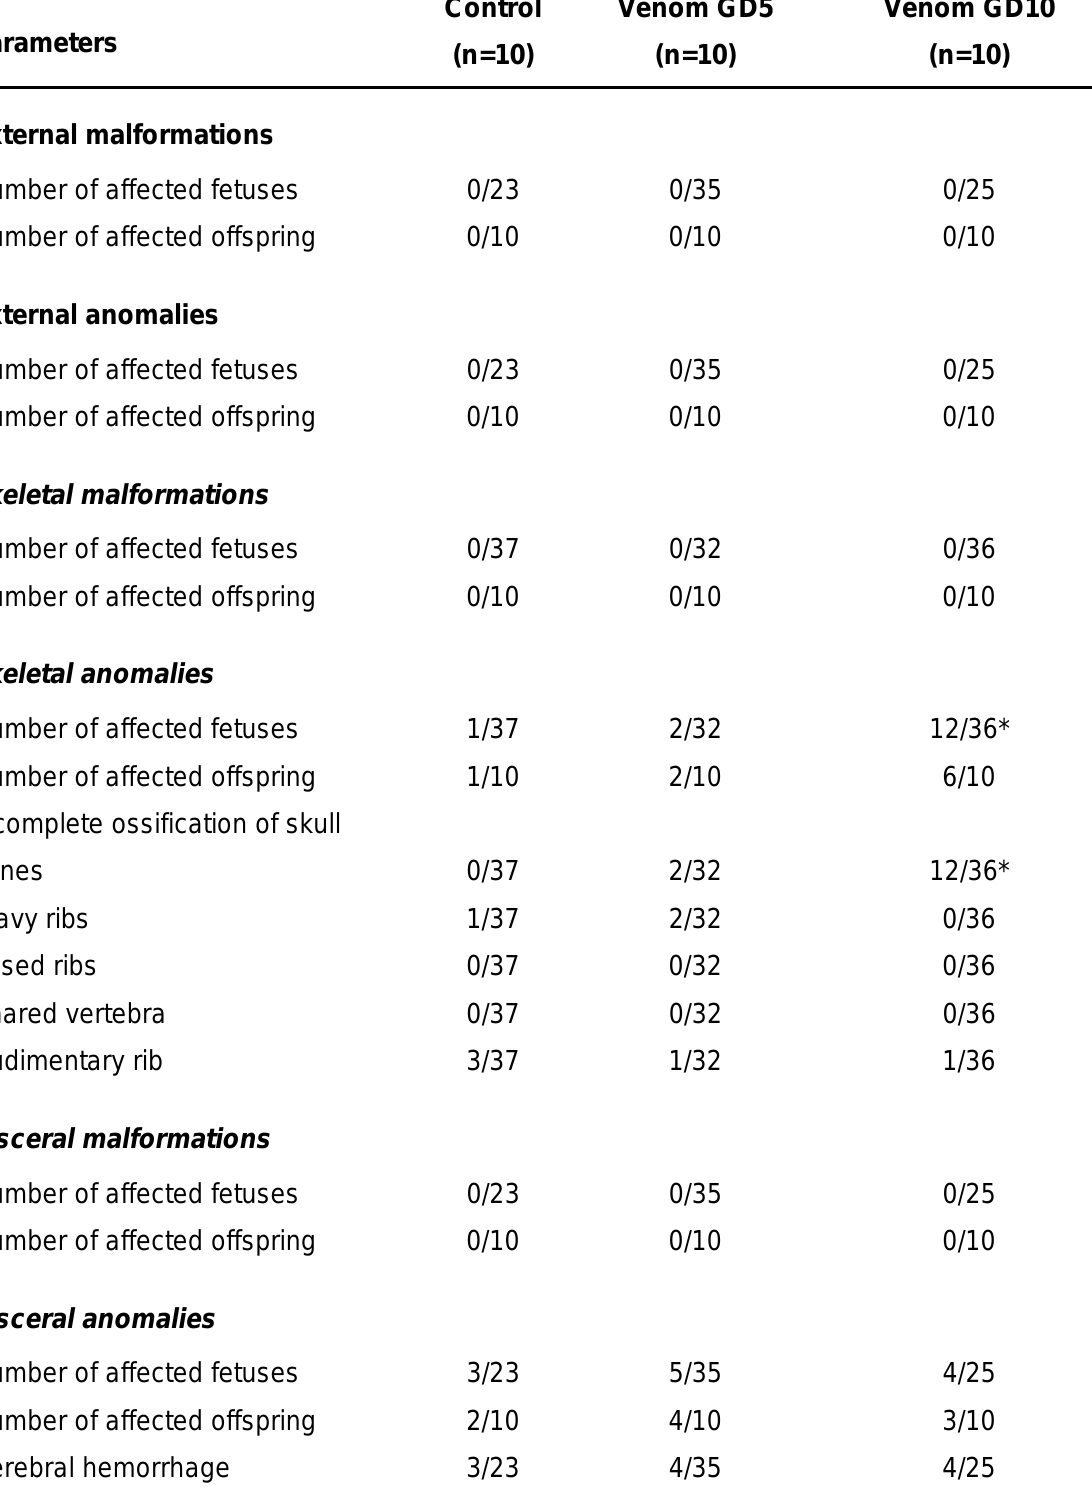
Table 3. Skeletal and visceral malformations or anomalies of fetuses of dams treated with Tityus serrulatus venom, 3.0mg/kg, on the 5 th and on the 10 th gestation day